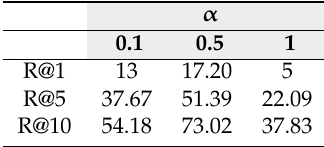
Table 6. Sensitivity with respect to the margin parameter α .